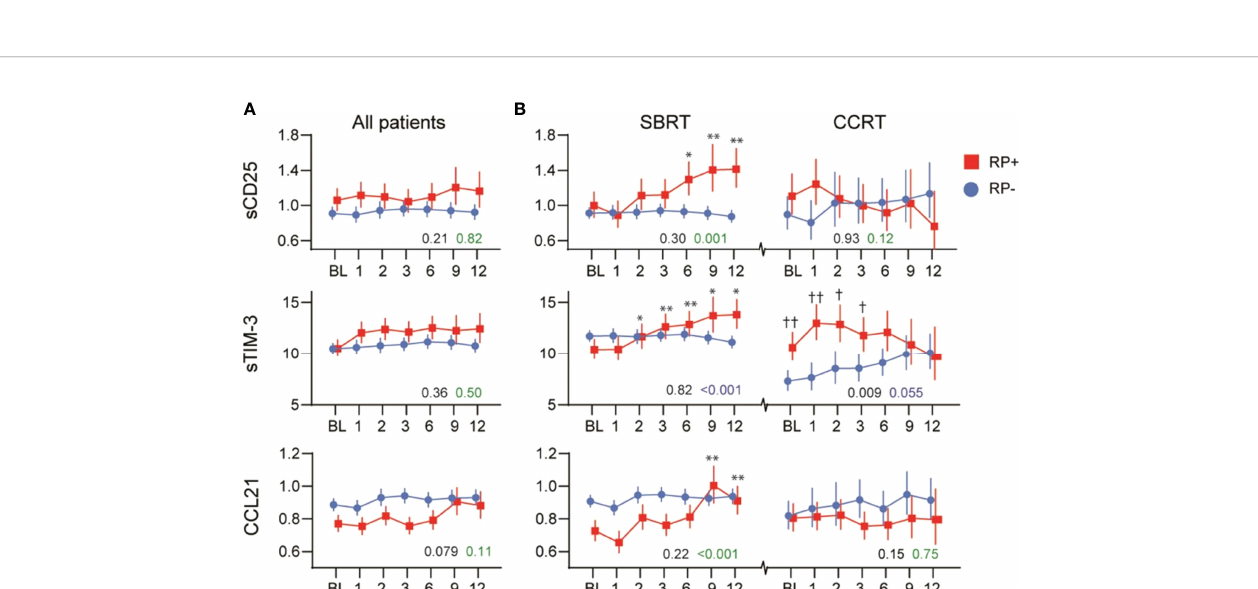
FIGURE 2 | Temporal pro fi le of sCD25, sTIM-3 and CCL21 in relation to radiation pneumonitis (RP) in (A) all patients and (B) within patients receiving stereotactic body radiation therapy (SBRT) or concurrent chemoradiation therapy (CCRT). The black p-value represents the effect of RP from the univariate general linear model, while the green p-value represents the interaction with time (RP*time). *p < 0.05, **p < 0.01 vs. baseline. † p < 0.05, †† p < 0.01 vs. RP- same